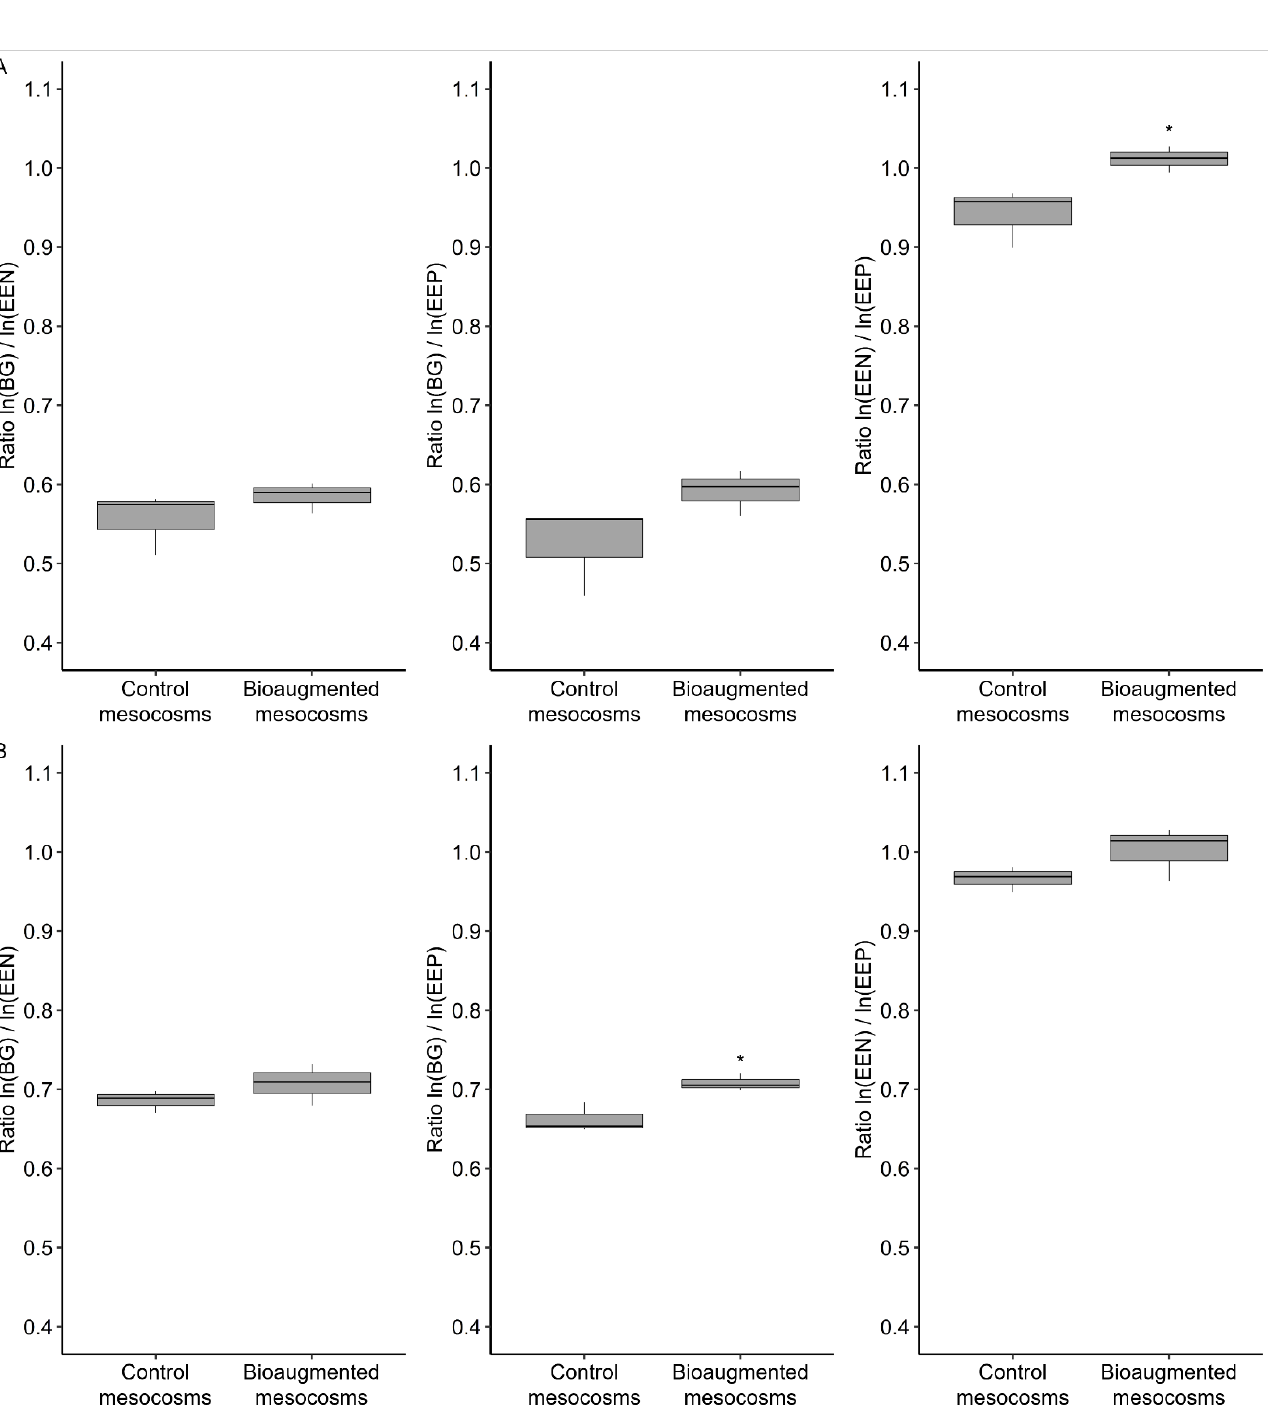
Figure 4. Enzyme logarithmic ratios in the soil H ( A ) and in the soil L ( B ) after a three-month-treatment. The corresponding enzymes are: BG ( β -1,4-glucosidase); EEN = NAG ( β -1,4-N-acetylglucosaminidase) + LAP (leucine aminopeptidase); EEP = PHOS (phosphomonoesterase). The line within the box shows the median value, the bar lines above and below the boxes indicate minimum and maximum values ( n = 3). The asterisk indicates significant differences between treatment (Student’s test; p -value < 0.05). EEN: extracellular enzymes of hydrolysis of N substrates; EEP: extracellular enzymes of hydrolysis of P substrates.